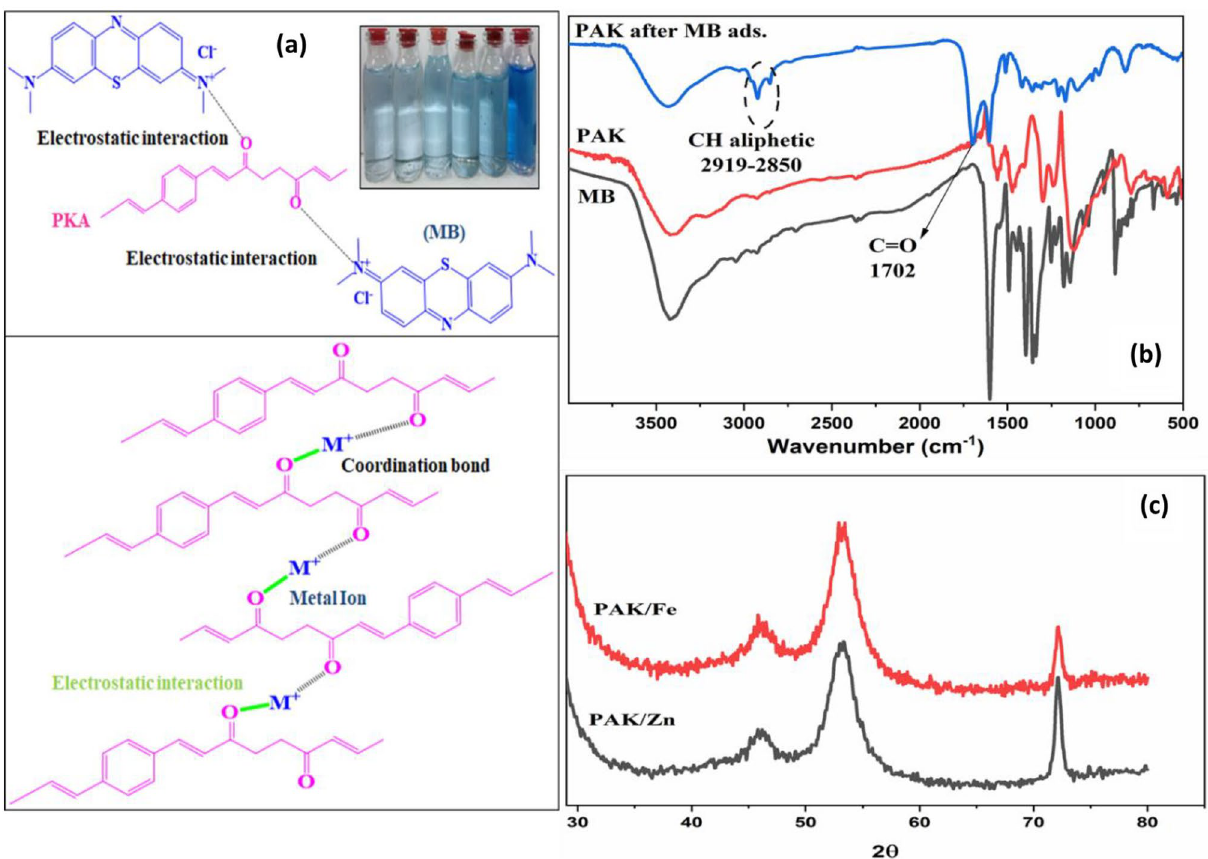
Figure 10. ( a ) Schematic illustration of MB adsorbed and the reaction mechanism of heavy metals removal from wastewater using PAK polymer. ( b ) FT-IR of PAK after MB Adsorption, ( c ) X-ray of PAK after Zn and Fe